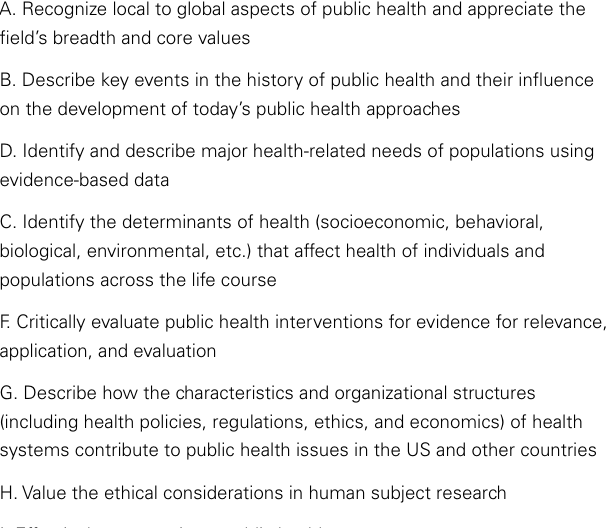
Table 1 | List of course objectives